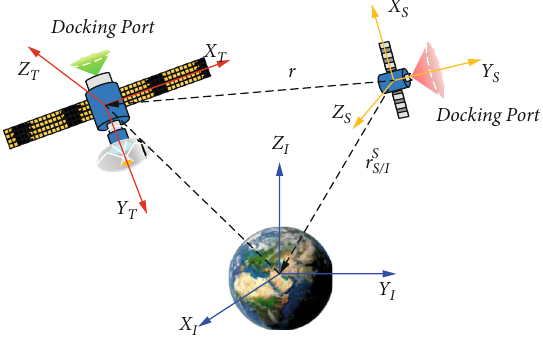
Figure 2: Depiction of in-orbit assembly and coordinate